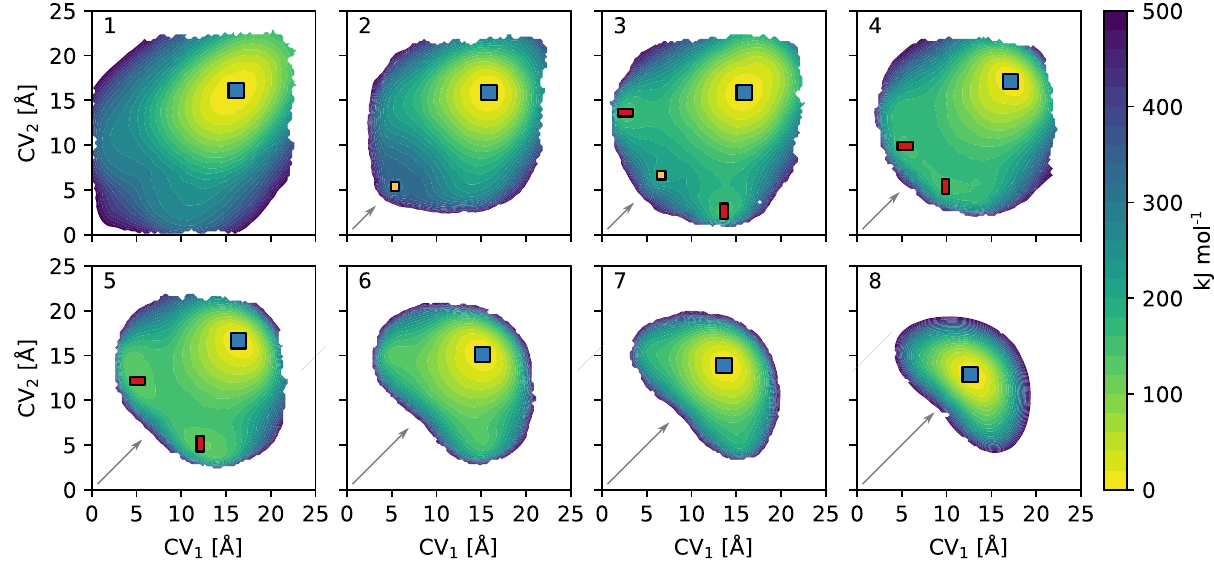
Fig. 4 Free energy surfaces for COF-300 at 300 K as a function of interpenetration. The degree of interpenetration varies from one (non- interpenetrated) to eightfold interpenetrated, as indicated in the top left corner of each subpanel. For each subpanel, the different (meta)stable phases are indicated. Regions with free energy exceeding the free energy minimum by more than 500 kJ mol − 1 are omitted from the plot, as they are not accessible under realistic conditions. The arrows indicate the growing steric crowding with increasing